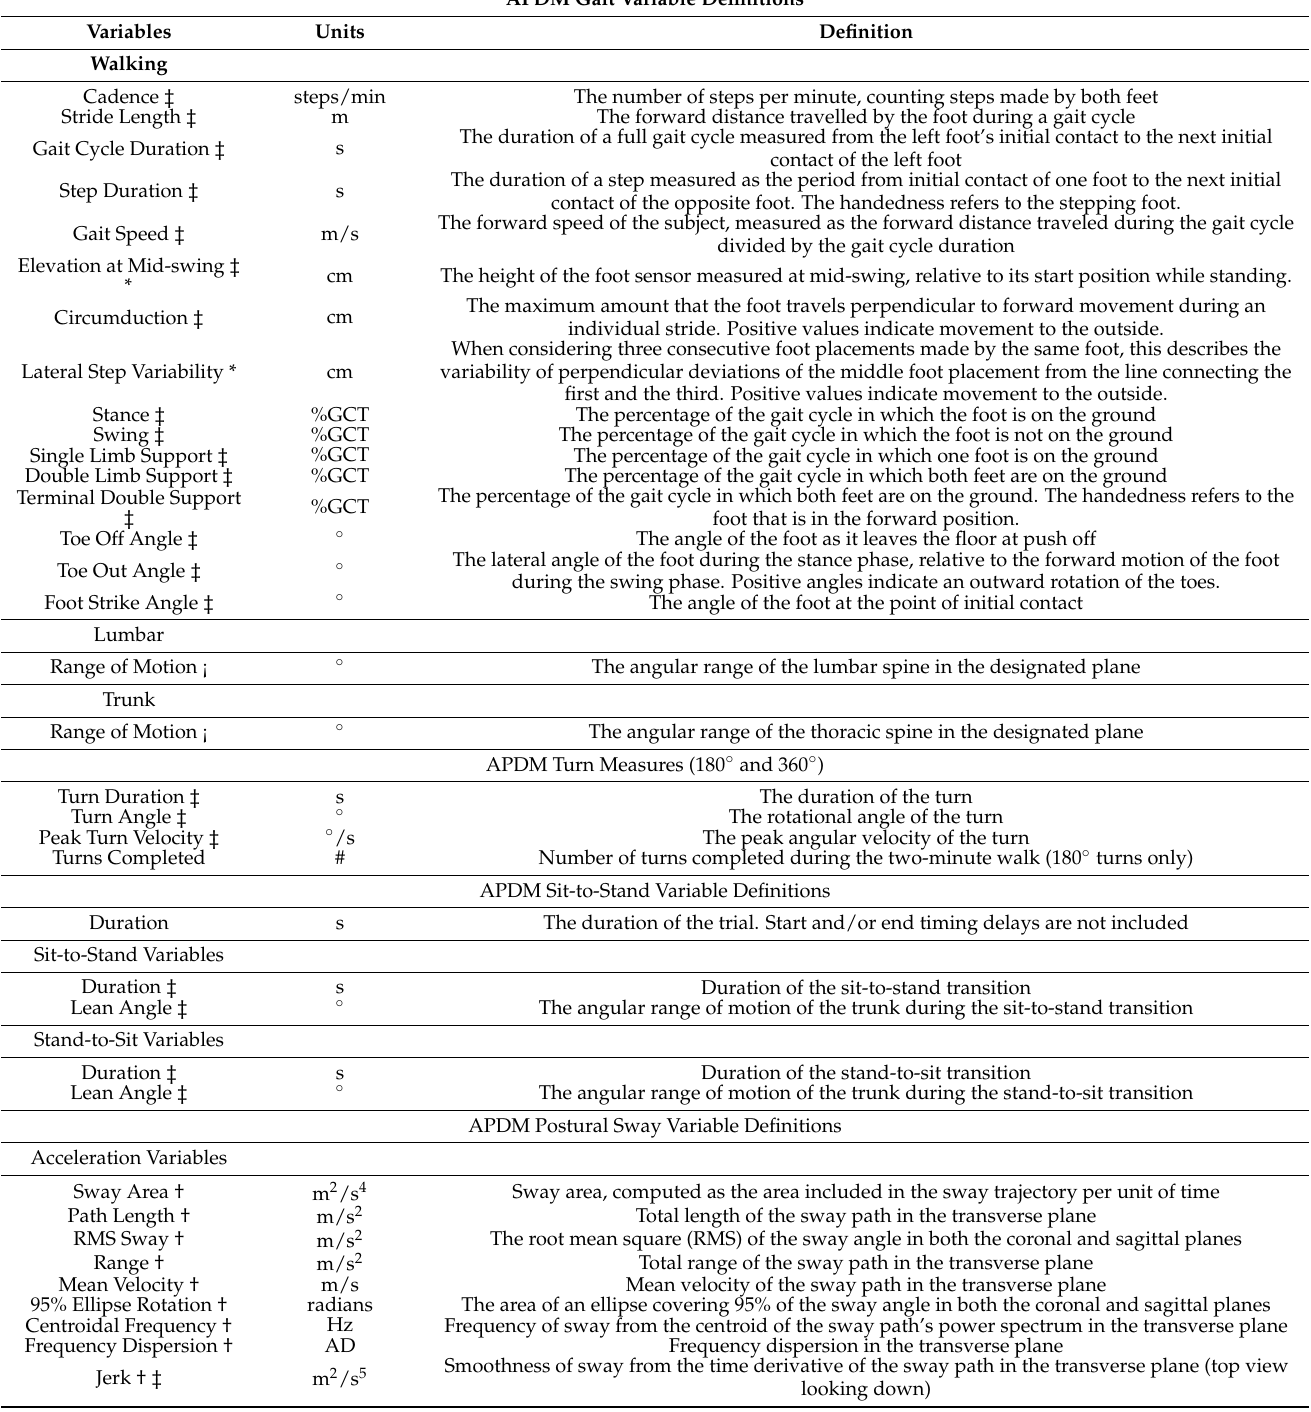
Table A1. Variable Definitions. Directional components for the measure in the sagittal and coronal (†), Mean and coefficient of variation measures (‡); Unilateral measures (i.e., separate left and right) (*); Multi-directional (¡): transverse, sagittal, and coronal; percent of the gait cycle time (%GCT); number